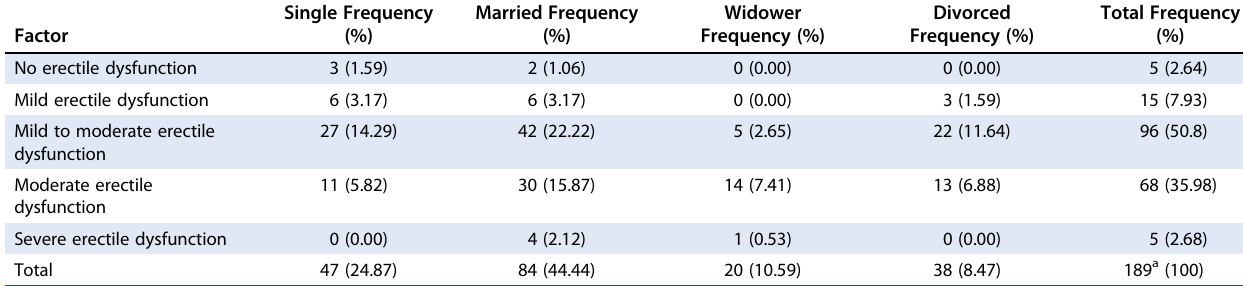
Table 4: Comparison of erectile dysfunction with demographic characteristics Factor